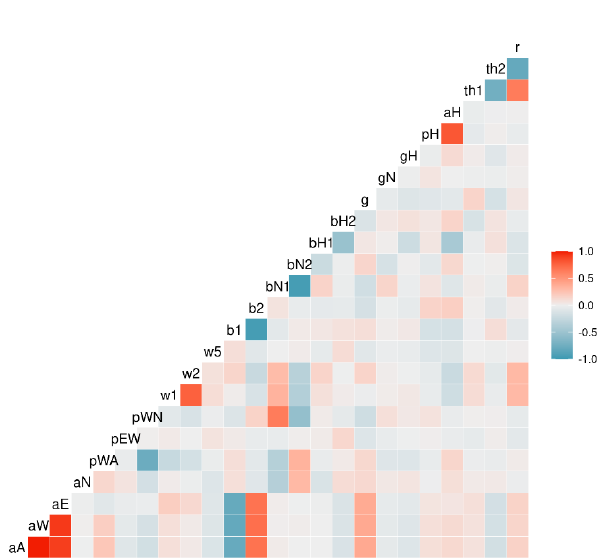
Figure 3. Parameter correlations for the global calibration with the DEzs algorithm.